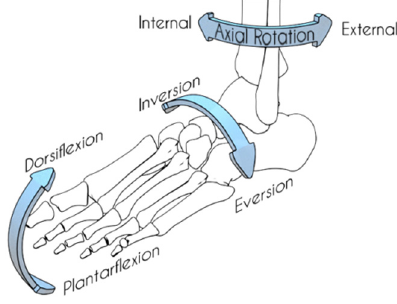
Figure 1. Different movements of the foot.